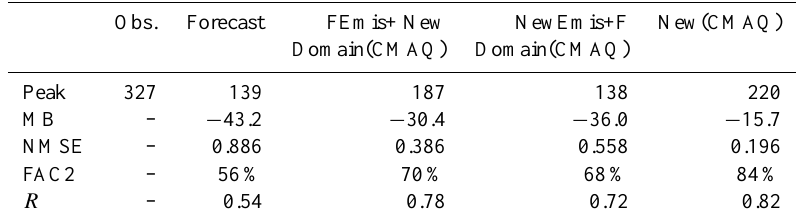
Table 3. Statistical measures of the modelled daily PM 10 -API of all stations in Beijing. Obs. Forecast FEmis+ New NewEmis+F New(CMAQ)